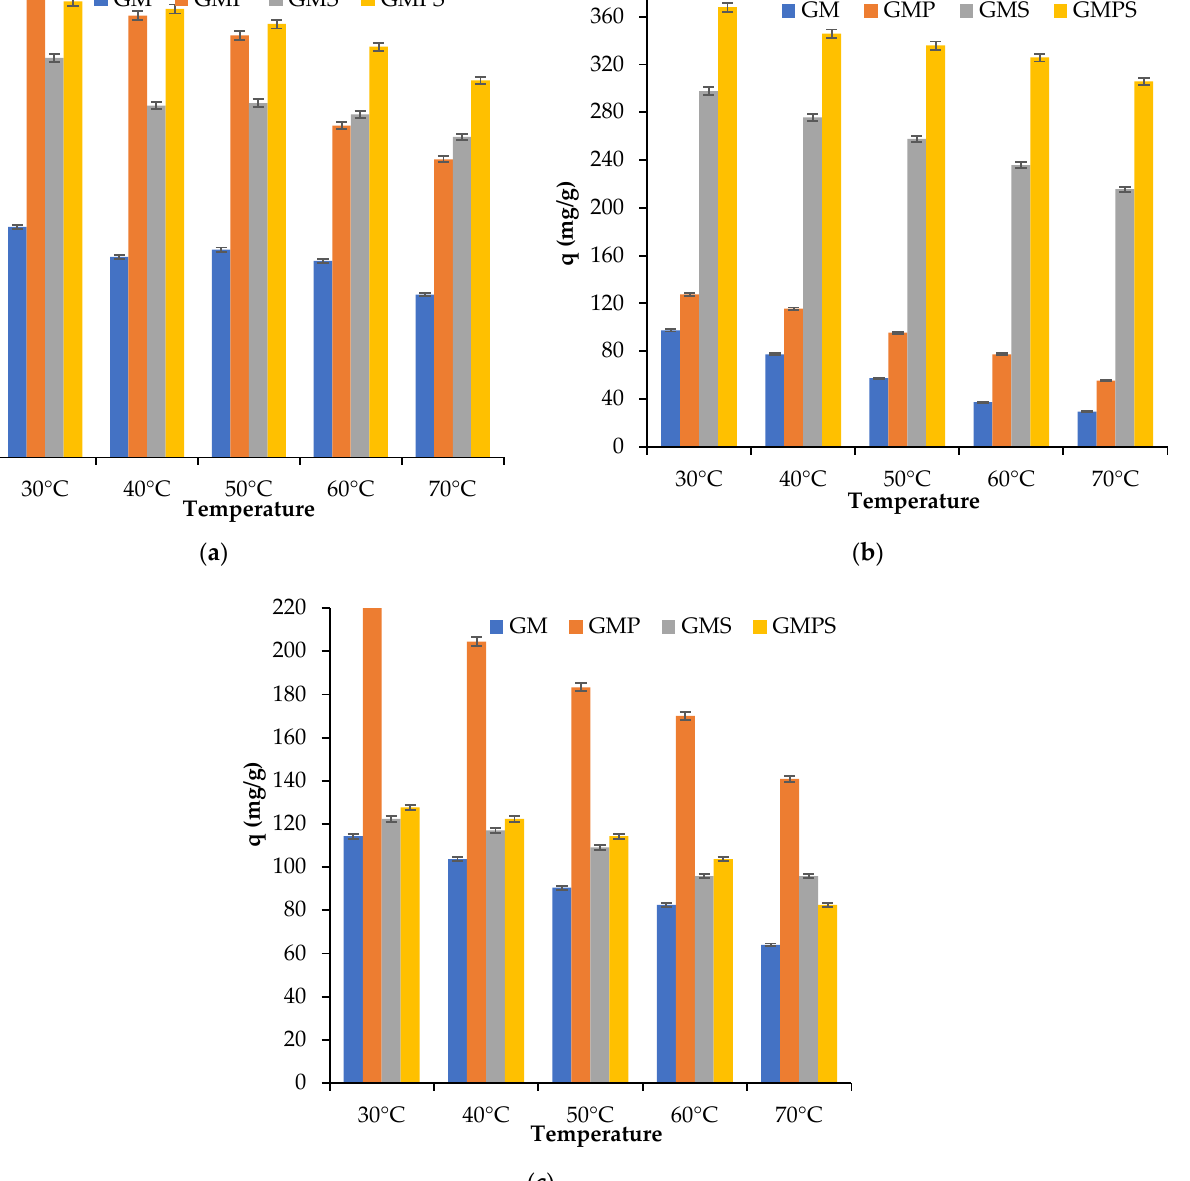
Figure 4. Effect of solution temperature on adsorption capacity ( a ) Foron black dye, ( b ) Foron blue dye, and ( c ) Foron red dye.